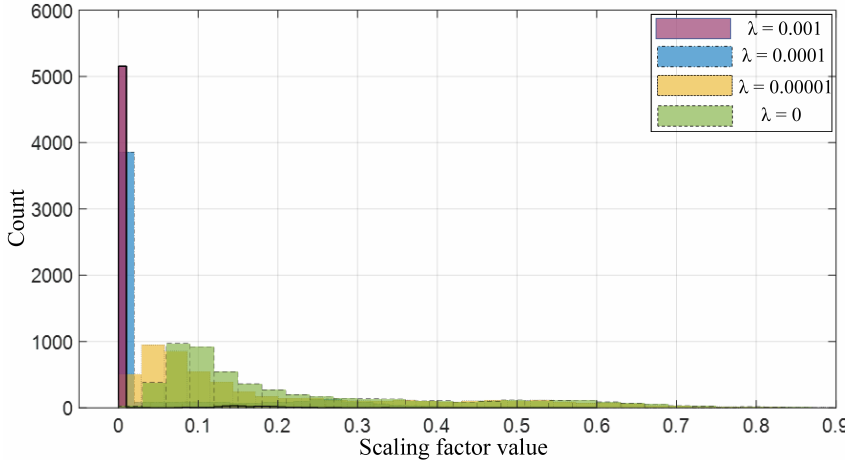
Figure 11. The distribution of scaling factors in four groups of VGG16 under different sparsity regularization (controlled by the parameter λ ). As λ increases, the scaling factor becomes